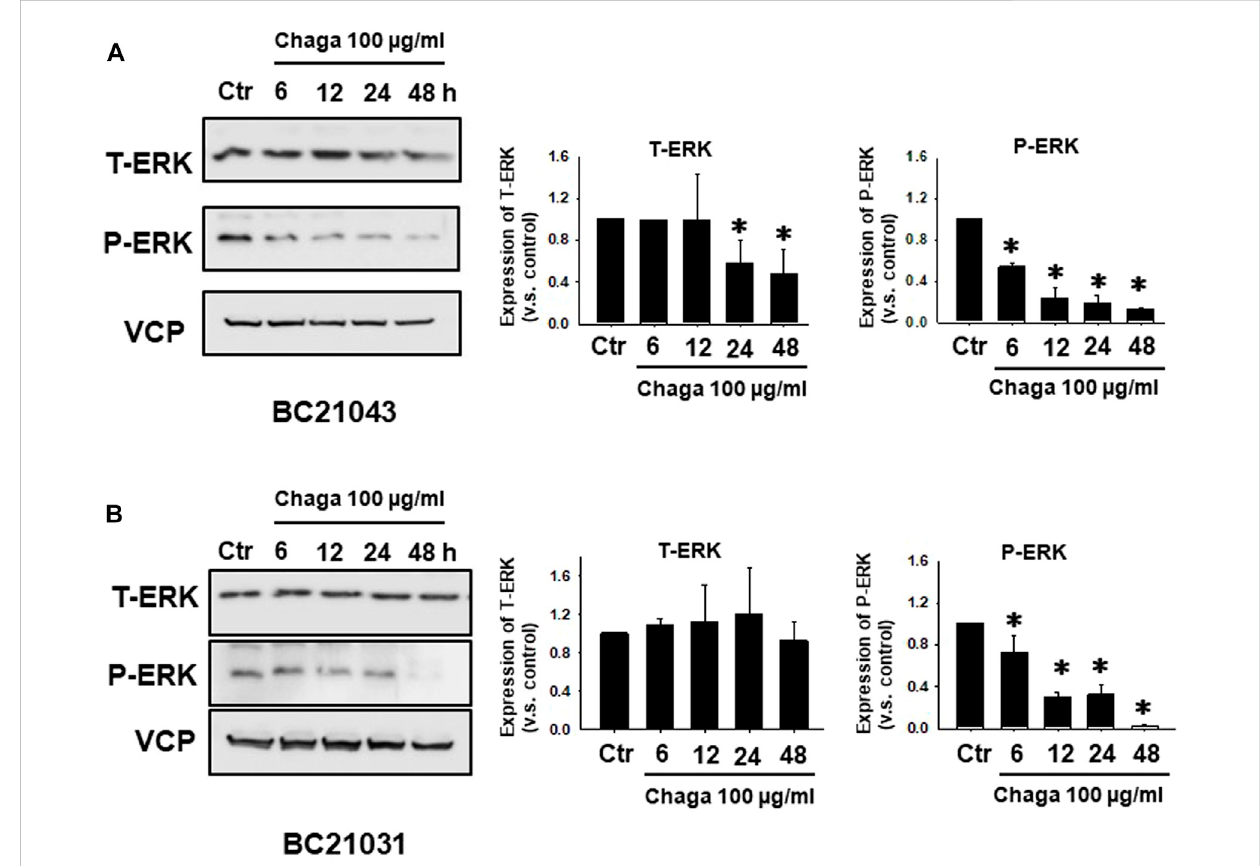
FIGURE 4 Effects of Chaga on activation of cell proliferation-related signaling in DBCO. Expression of phosphorylated ERK (P-ERK) and total ERK (T-ERK) in DBCO after Chaga treatment (100 μ g/ml for 6, 12, 24, and 48 h) were determined by Western blot analysis (A, B) , (n = 3). The expression levels were quanti fi ed and plotted based on the ratio of expression level to control (A, B) , n = 3). Results were expressed as mean ± S.E.M. Equal protein loading was con fi rmed using total VCP antibody. * p < 0.05 vs.